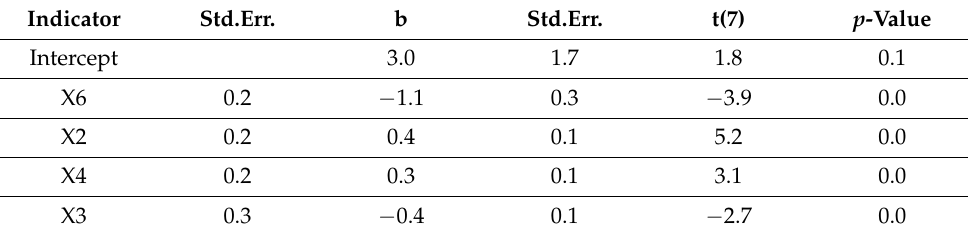
Table 3. Regression analysis results for variable Y1. Indicator